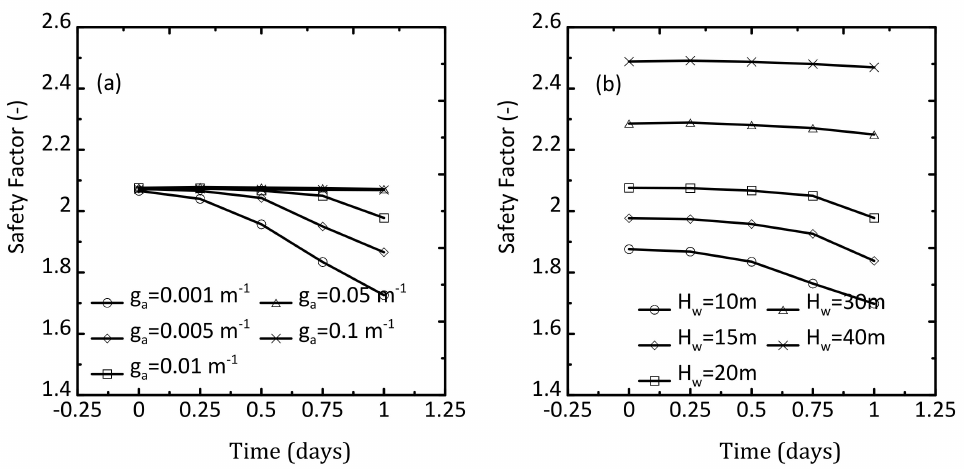
Figure 10. Slope safety factor variation with rainfall time duration, for various values of ( a ) g a and ( b ) H